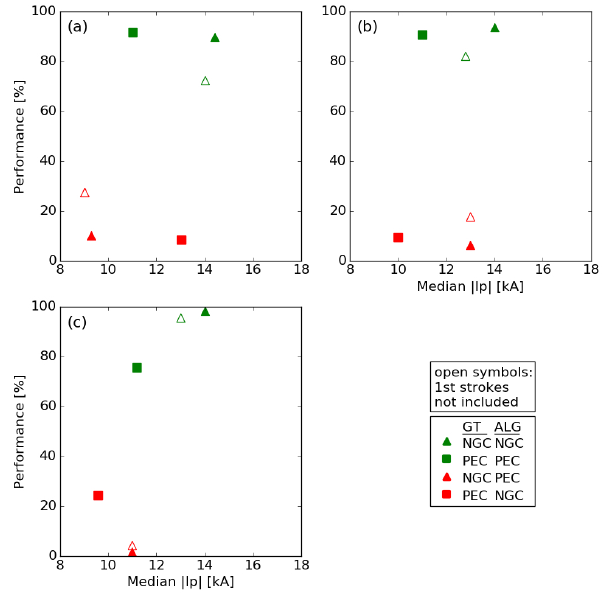
Figure 3. Algorithm performance as a function of median abso- lute peak current for (a) A1, (b) A2 and (c) A3. The threshold for which the results are presented is 500m for A1 and A2, and 10km for A3. The different symbols and colors denote the four possibili- ties, whereby a green (red) color indicates that the algorithm (ALG) correctly (incorrectly) assigned the type of stroke compared to the ground-truth observations (GT). Ignoring first strokes in the flash results in the open symbols in the